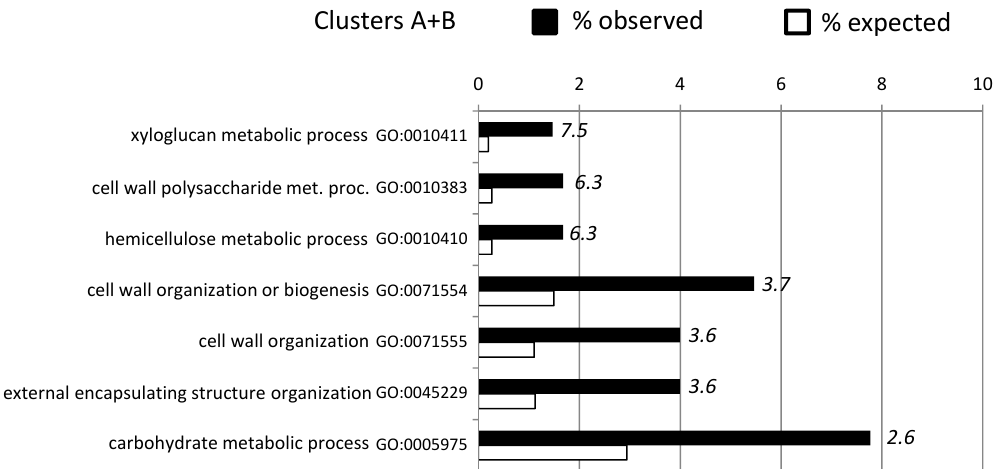
Figure 6. GO term enrichment analysis ( p < 0.05 FDR corrected) for biological processes of genes in cluster A and B (see Figure S5). For each GO term, the expected (white bars) and the observed (black bars) percentage is presented. Numbers in italics indicate the fold enrichment. Only GO terms with more than 2-fold enrichment are